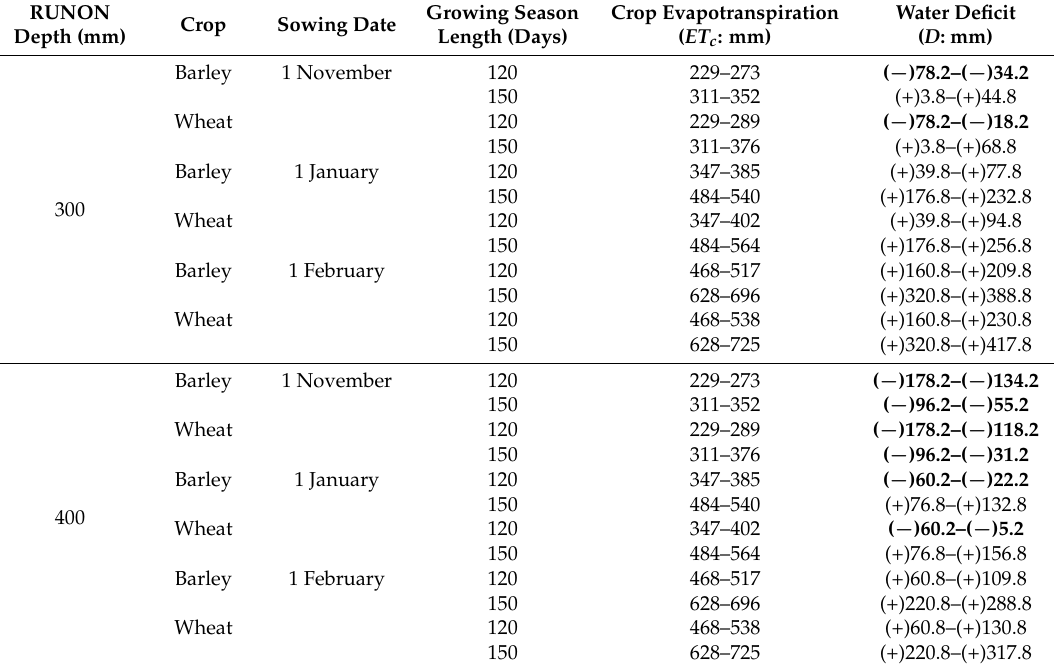
Table 6. Water deficit for the southern Arava Valley (relevant for the El-Sa’edin Playa) according to RUNON depth, crop, sowing date, and crop